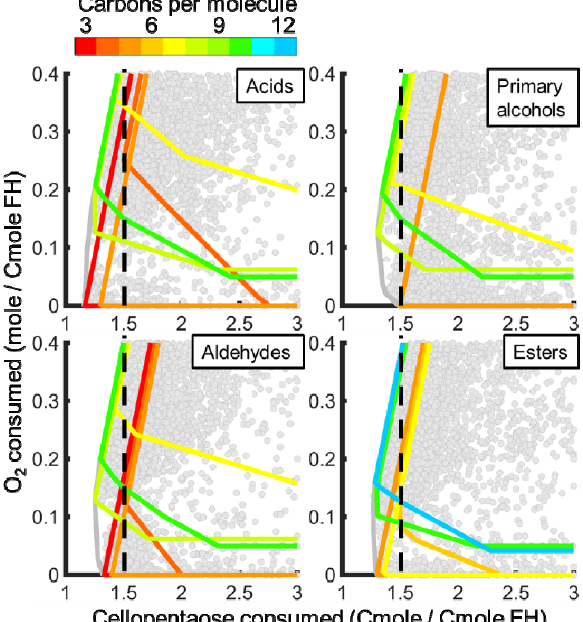
Figure 4. Ehrlich pathway derivative production strategies that minimize carbon and O 2 require- ments in A. sarcoides NRRL 50072 with respect to chain length and defining functional group. Metabolic strategies that minimize carbon source and O 2 requirements to produce functionalized hydrocarbons (FHs) were identified (grey boundary, all possible metabolic strategies, elementary flux modes, are grey points). The colored lines denote metabolic strategies that produce FHs with a given number of carbons per molecule. Formate, acetate, acetaldehyde, and ethanol were not considered to be FHs for this study. Profiles for propanol, isobutyl alcohol, and isopentyl alcohol overlap. A reference carbon resource cost of 1.5 Cmole per Cmole of FH is denoted by the vertical dashed line to facilitate comparisons.